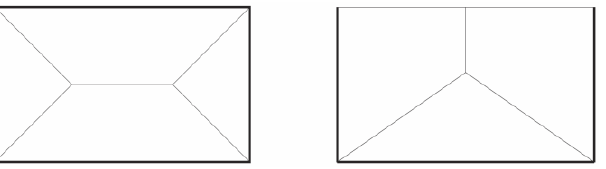
Figure 12. Fully supported (on the ( left )) and partially supported (on the ( right )) walls with repre- sented yielding-lines.